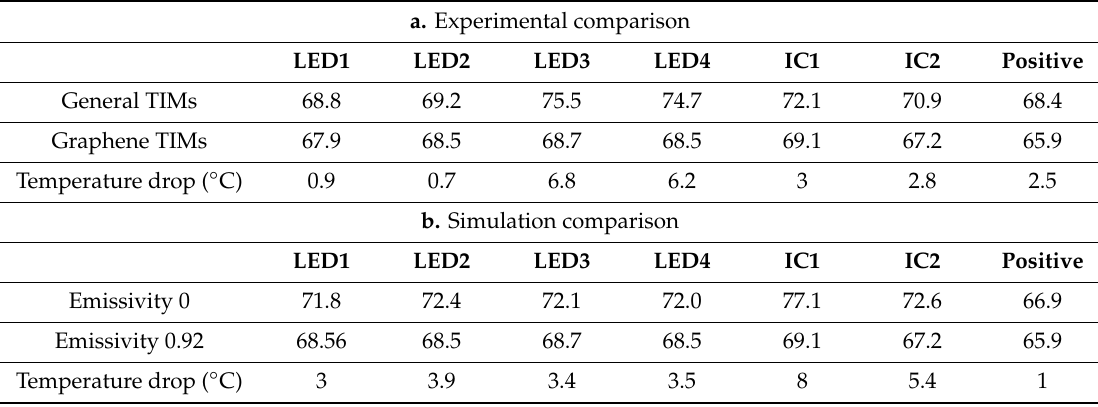
Table 2. Comparison of temperature di ff erence between graphene TIMs and general